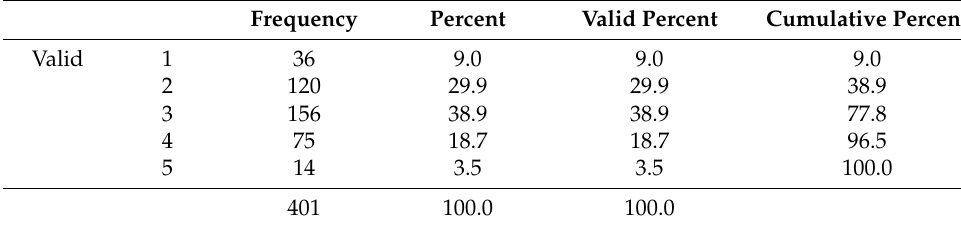
Table 3. Level of satisfaction with the current LAS.